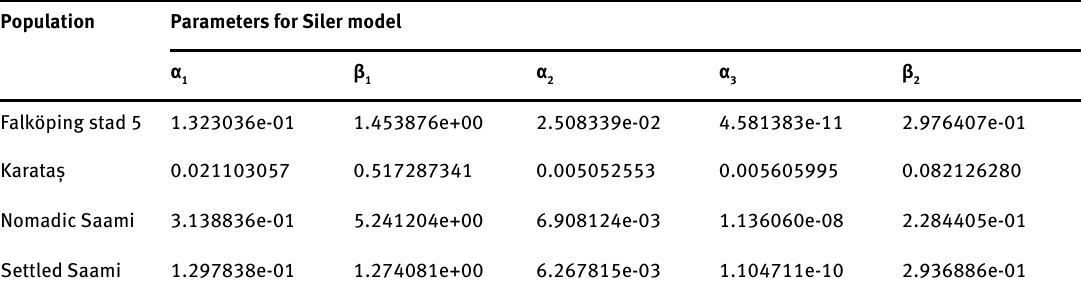
Table 3. Siler models with parameters from Falköping stad 5, Bronze Age population of Karataș (Angel, 1969, available in Weiss & Wobst (1973) and church records of Saami populations (Wahlund,